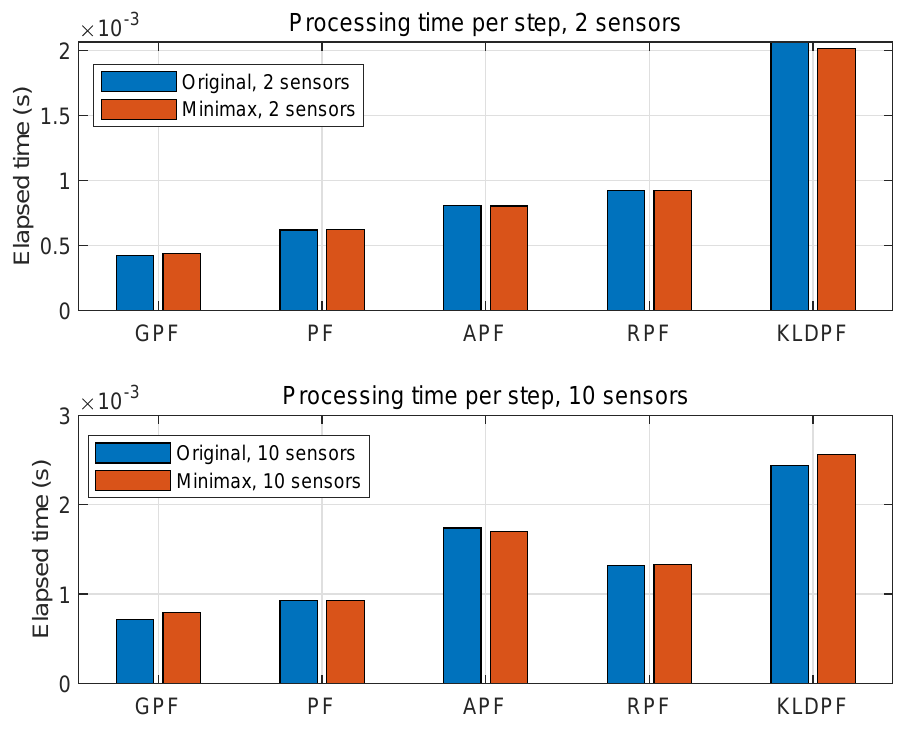
Figure 16. Mean-elapsed time for the one time step over 300 runs with 1000 particles for all PFs. Note that there is no resampling process required for